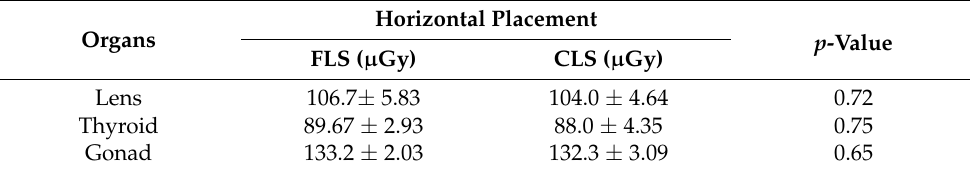
FLS: fogged lead glass shielding; CLS: clean lead glass shielding.